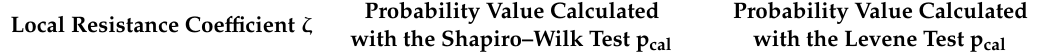
Table3. ResultsofcalculationsofthestatisticsusingtheShapiro–WilktestandLevenetest. Di ff erencesof the mean values are significant with the probability p > 0.05.